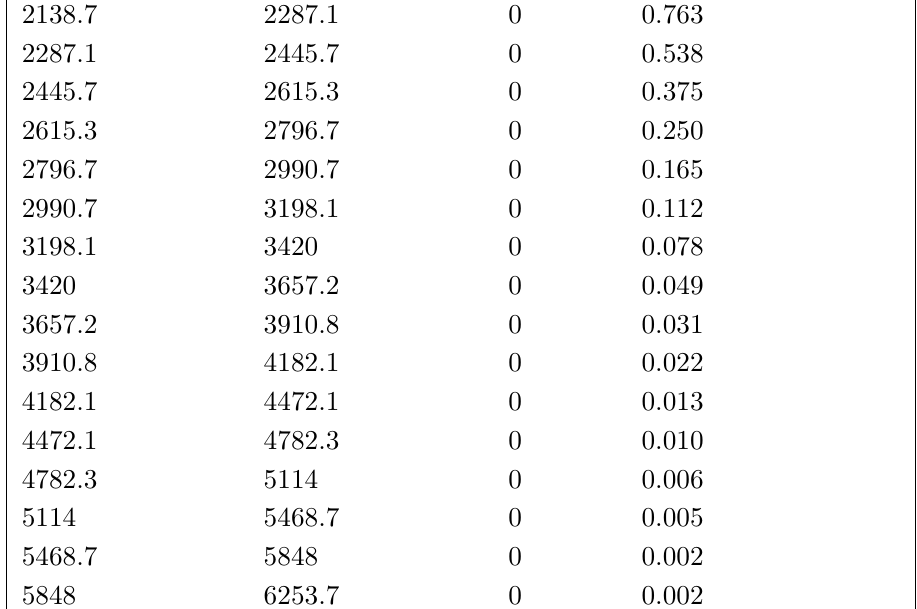
Table 9. Expected and observed event yields in the dimuon channel, directly corresponding to the non-linear binning presented in (cid:12)gure 1b. The expected yield is given up to at most 4 digit